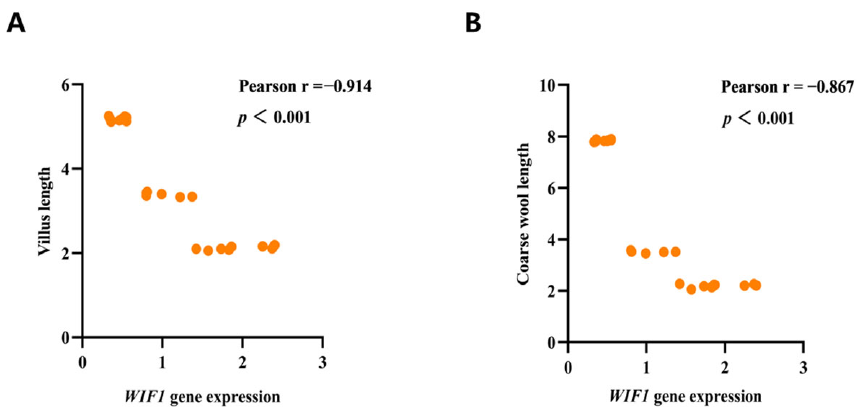
Figure 3. Pearson correlation analysis between relative expression of WIF1 gene and Villus, Coarse wool length in Rex, New Zealand and Angora Rabbits. ( A ) Pearson correlation analysis between relative expression of WIF1 gene and Villus length. ( B ) Pearson correlation analysis between relative expression of WIF1 gene and Coarse wool length. p < 0.001 indicates a significant difference. The range of the Pearson correlation coefficient is between − 1 and 1. If the value of r is positive, it means a positive correlation. If the value of r is negative, it means a negative correlation. The closer the absolute value of r to 1, the higher the correlation degree.